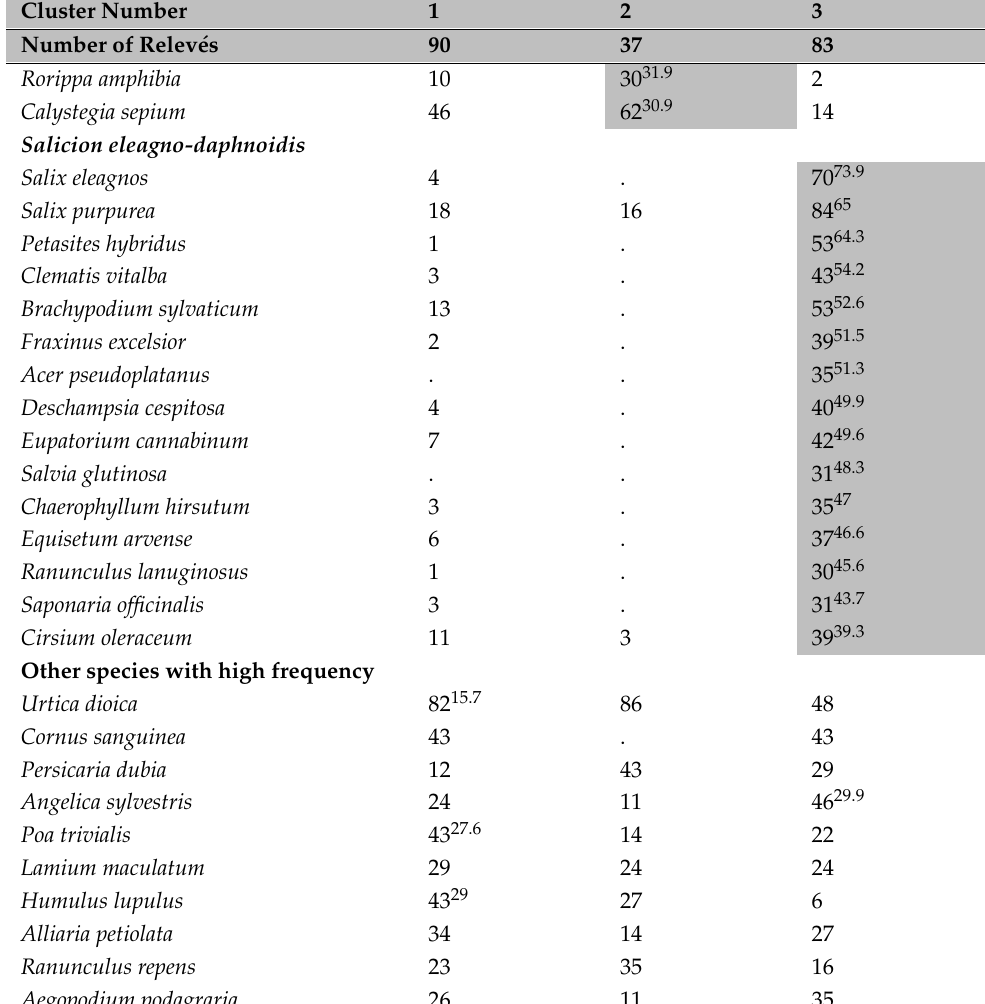
Table A2. Synoptic table for the cluster group Alno-Populetea . Frequencies of species are presented as percentages, with phi values multiplied by 100 shown in superscript. Diagnostic species (phi values higher than 0.30) are shaded. Species with frequency lower than 30% in a cluster for which they are diagnostic are not shown. Only up to 15 species with the highest phi value are